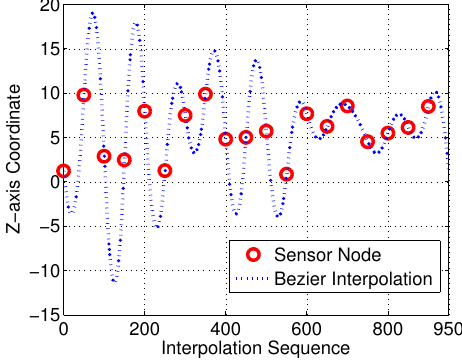
Figure 11. Bezier interpolation between sensor nodes in Z -axis.